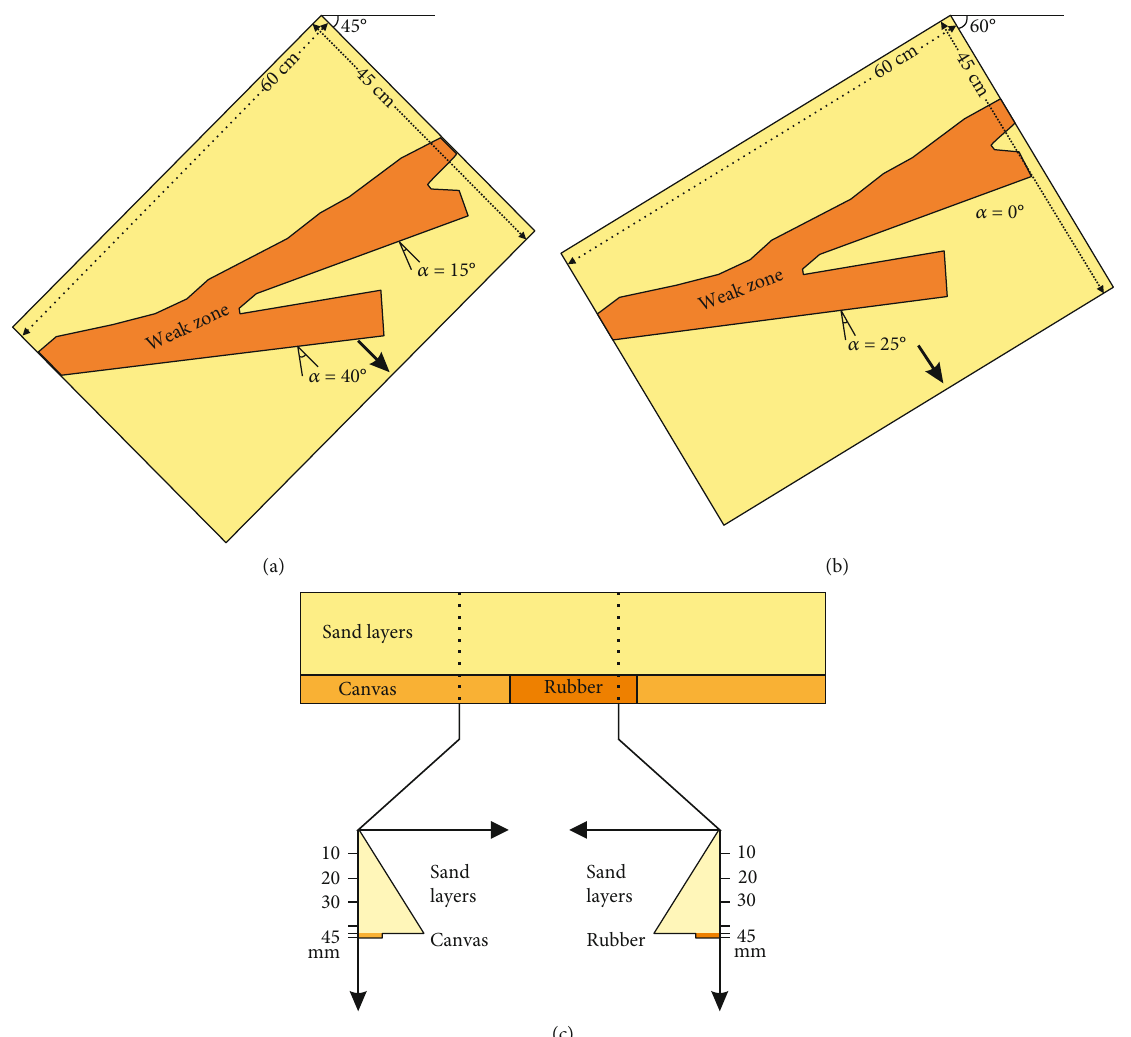
Figure 2: Schematic diagram of the experimental model. (a) Plan view of the extension direction oriented N315 ° E – N135 ° E, (b) plan view of the extension direction oriented N330 ° E – N150 ° E, and (c) cross-sectional